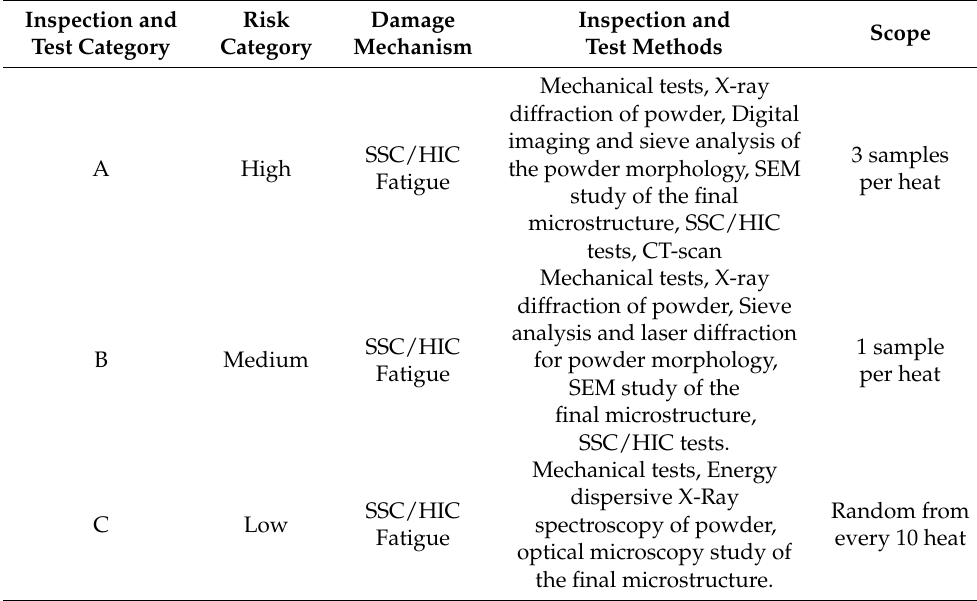
Table 6. Example of categorizing inspection and test methods for risk-based qualification procedure. Inspection